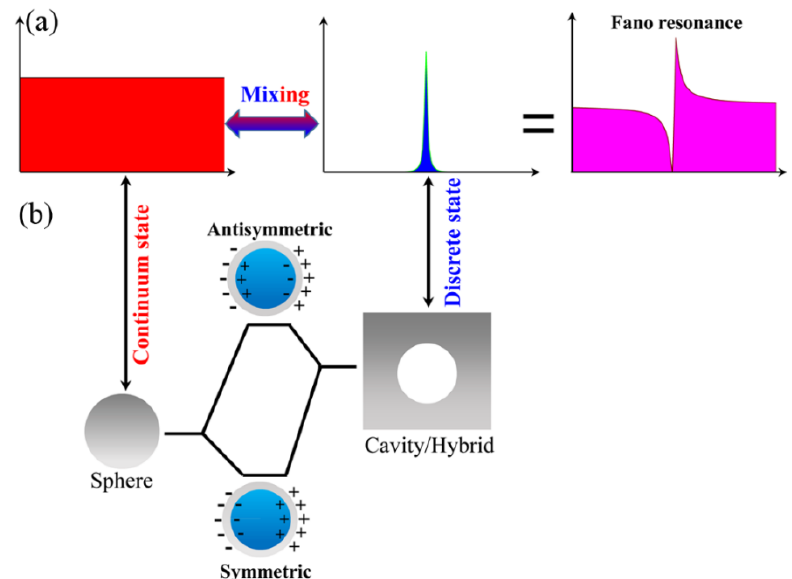
Figure 4. ( a ) Formation of the FR as a superposition of the Lorentzian line shape of discrete state with a flat continuous background. ( b ) Schematic of the plasmon hybridization. The hybridization of a sphere and a cavity plasmon leads to the formation of a symmetric and antisymmetric plasmon resonances of the Ag nanoshell.